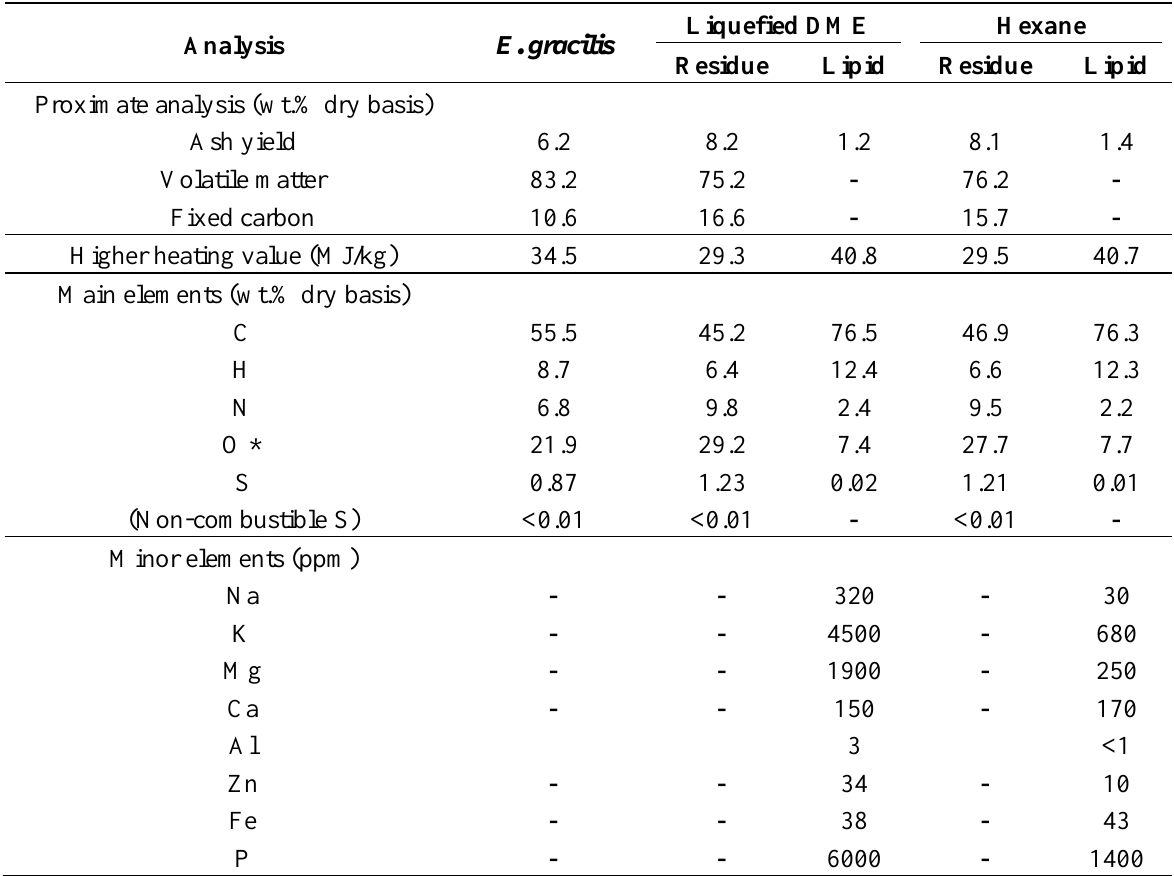
Table 1. Proximate analysis, higher heating value, and elemental analysis.